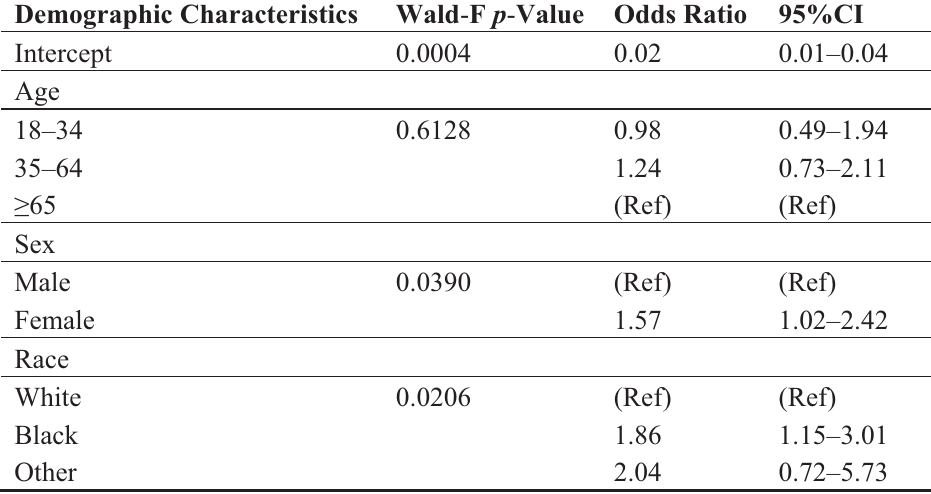
Table 2. Adjusted odds † of having a family history of sudden cardiac death of the young * among Michigan adults by demographic characteristics, 2007 Michigan Behavioral Risk Factor Survey [19]